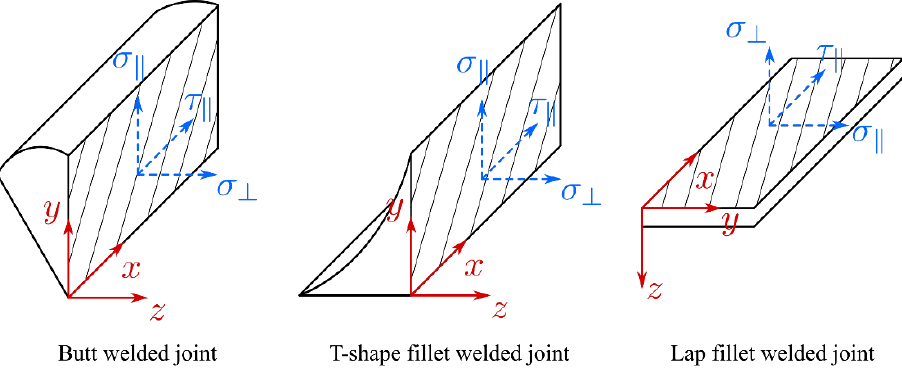
Figure 1. Stress components decomposition of welded joints in the local coordinate system.